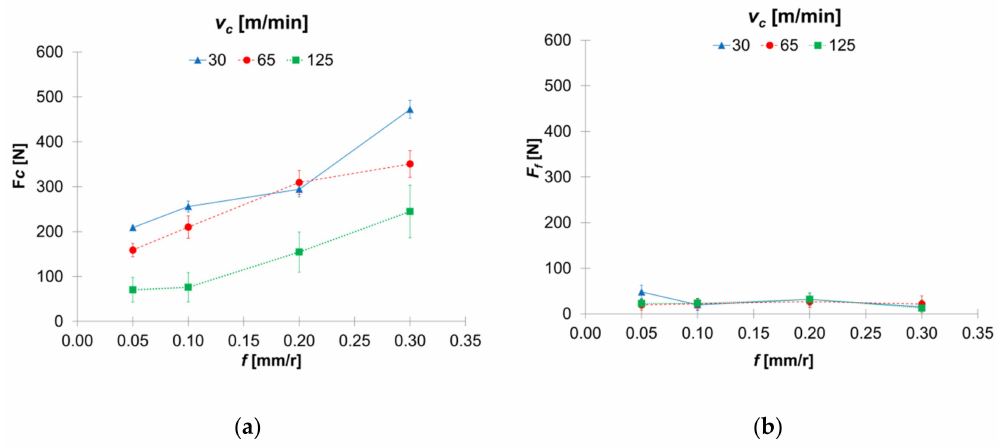
Figure 5. F c and F f amplitude average values as a function of v c and f ( a ) F c = ( f, v c ); ( b ) F f = ( f, v c